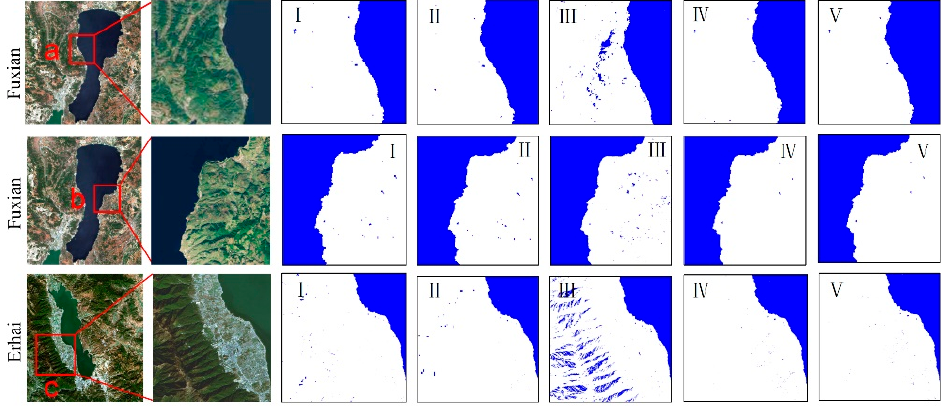
Figure 11. Comparison of LWB extraction in montane lakes for Methods I–V. The subfigures ( a – c ) of Figure 11 are used to show the differences among the extraction results.